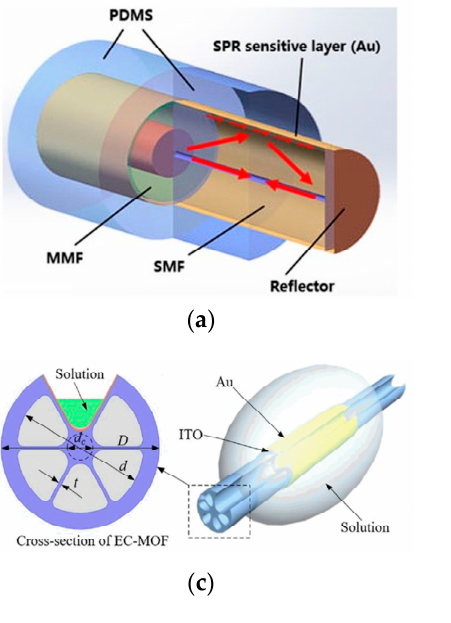
Figure 4. ( a ) Structure of the composite reflection probe [25]. ( b ) Structure and sensing mechanism of the two-channel SPR sensor based on HCF [26]. ( c ) Schematic of the EC-MOF sensor [29]. ( d ) Schematic diagram of the SPR-based optical fiber sensor [34].